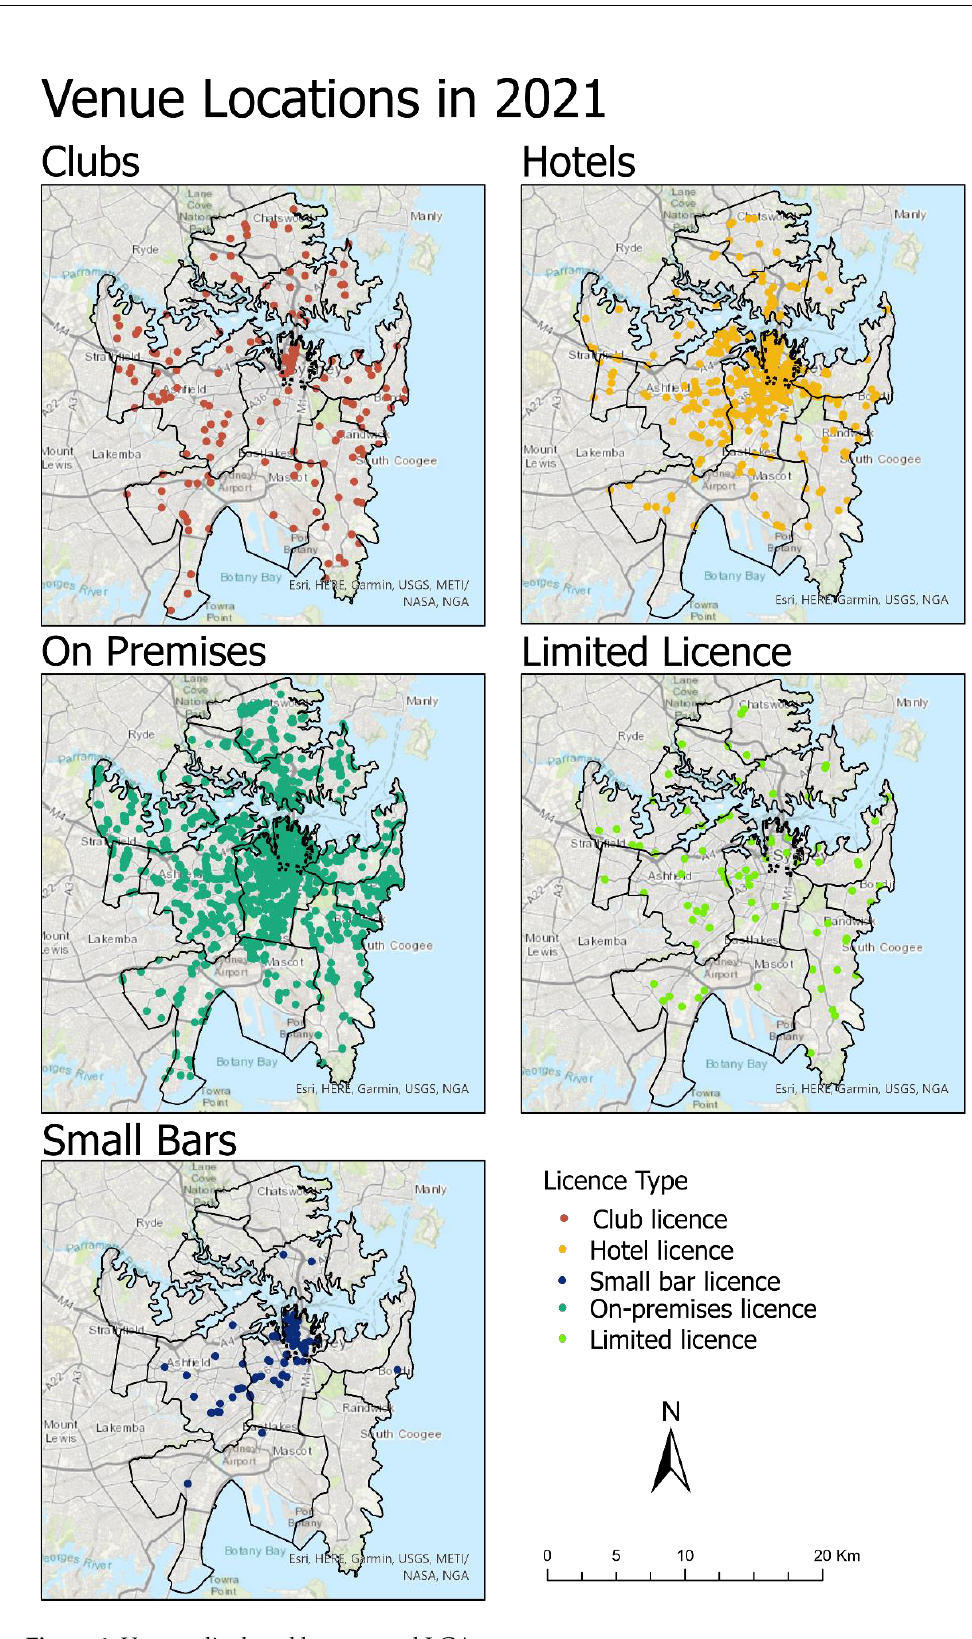
Figure 4. Venues displayed by type and LGA.